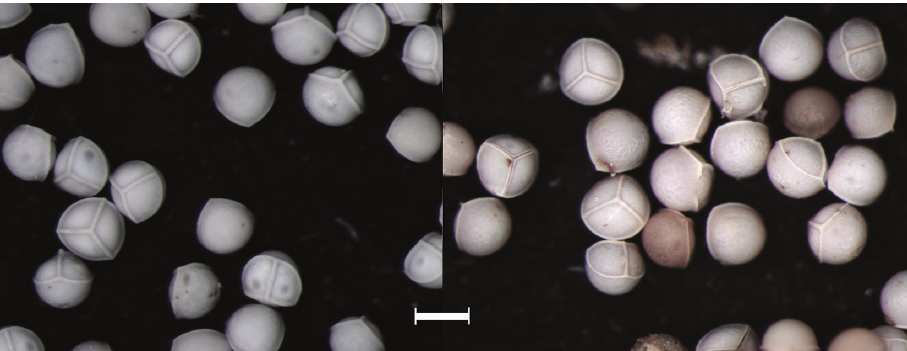
Figure 3. Light microscope image of megaspores of I. mississippiensis from Schafran MS-07 (left) and MS-08 (right). Magnification 63×. Scale bar = 0.3 mm.